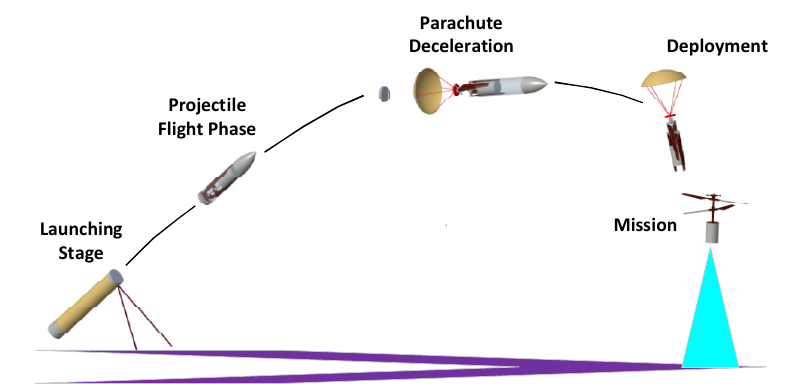
Figure 1. Flowchart of gun launch coaxial rotor aircraft.